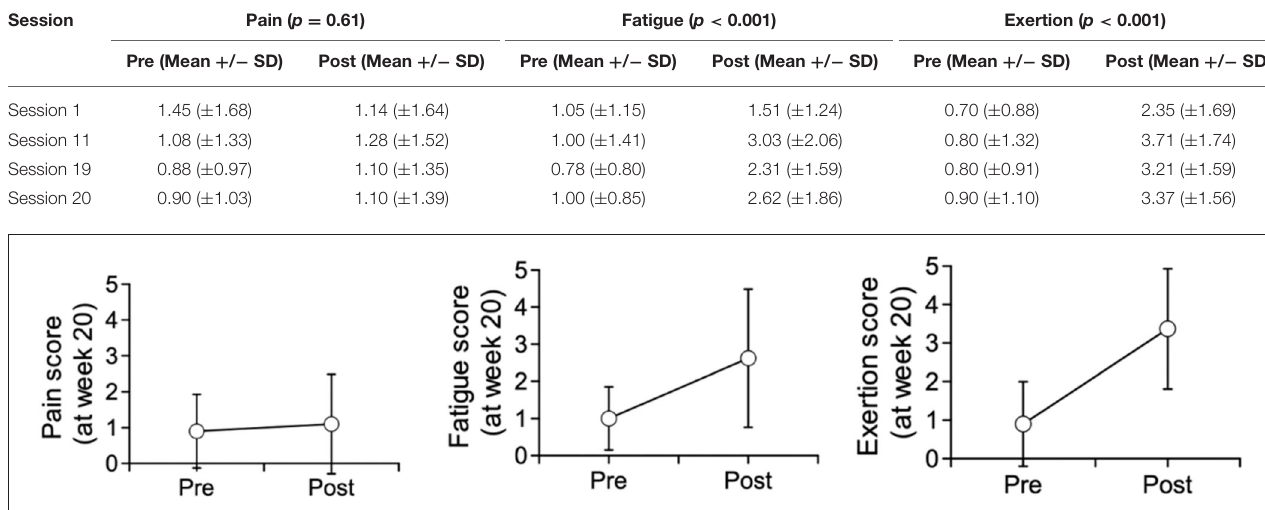
FIGURE 4 | Final session evaluation on pain, fatigue, and exertion trends before and after